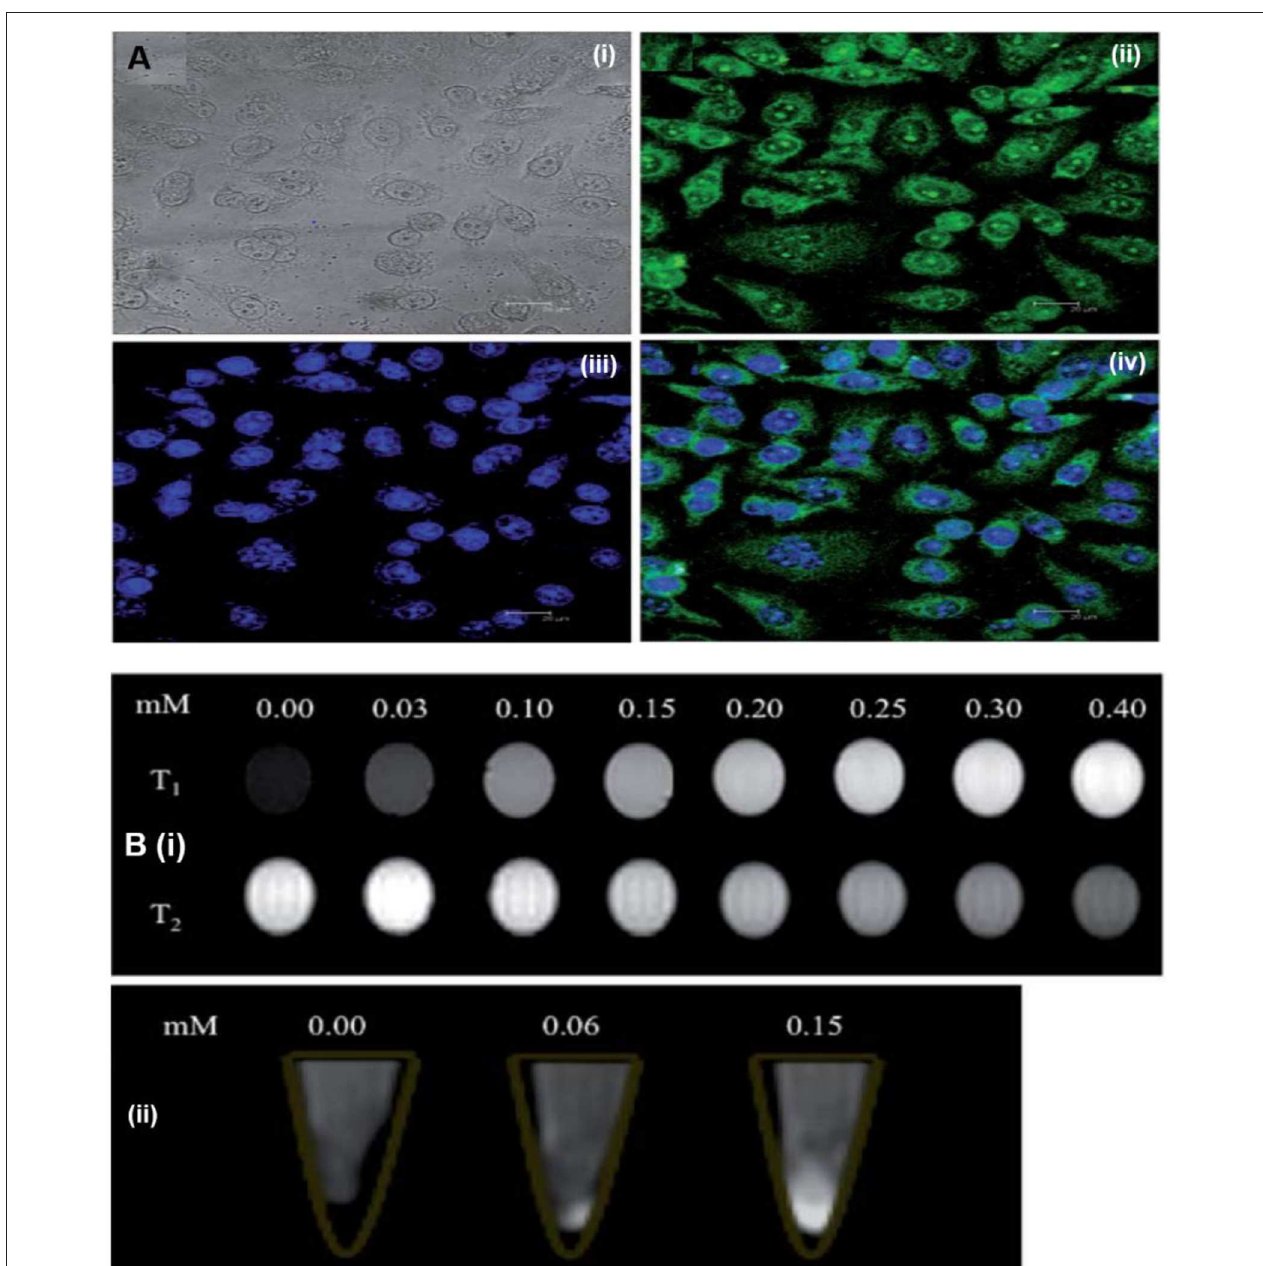
FIGURE 13 | (A) In Vitro internalization of folate-GdGQDs in HeLa cells. (B) T 1 and T 2 -weighted MRI images of diethylenetriaminepentaacetic acid gadolinium and then decorated with FA receptor (folate-GdGQDs) at various Gd concentrations (i) and T 1 - weighted MRI images of HeLa cells incubated with various concentration of folate-GdGQDs (ii); reproduced from Huang et al. (2015) with permission from the Royal Society of